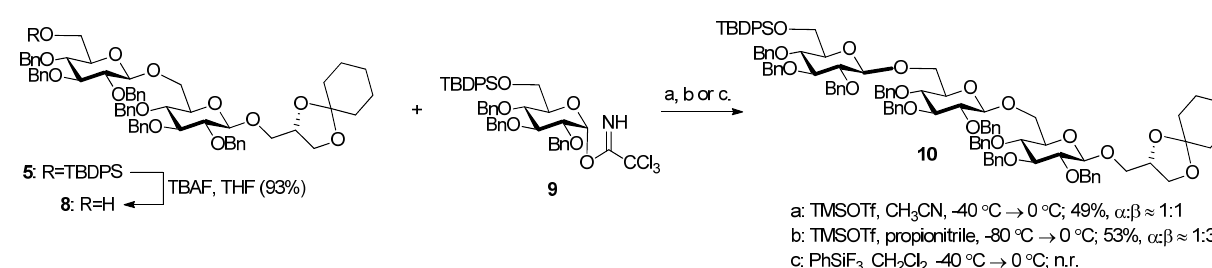
Scheme 4. Synthesis of pseudotetrasaccharide 10